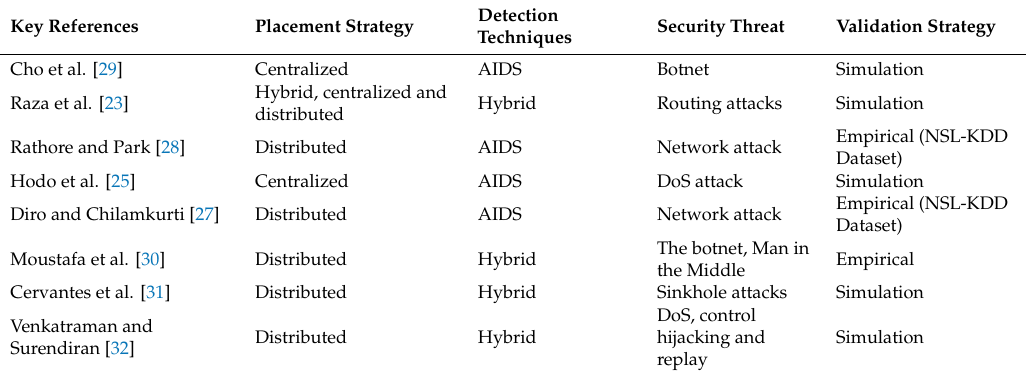
Table 2. Summary of the proposed research to IDSs for